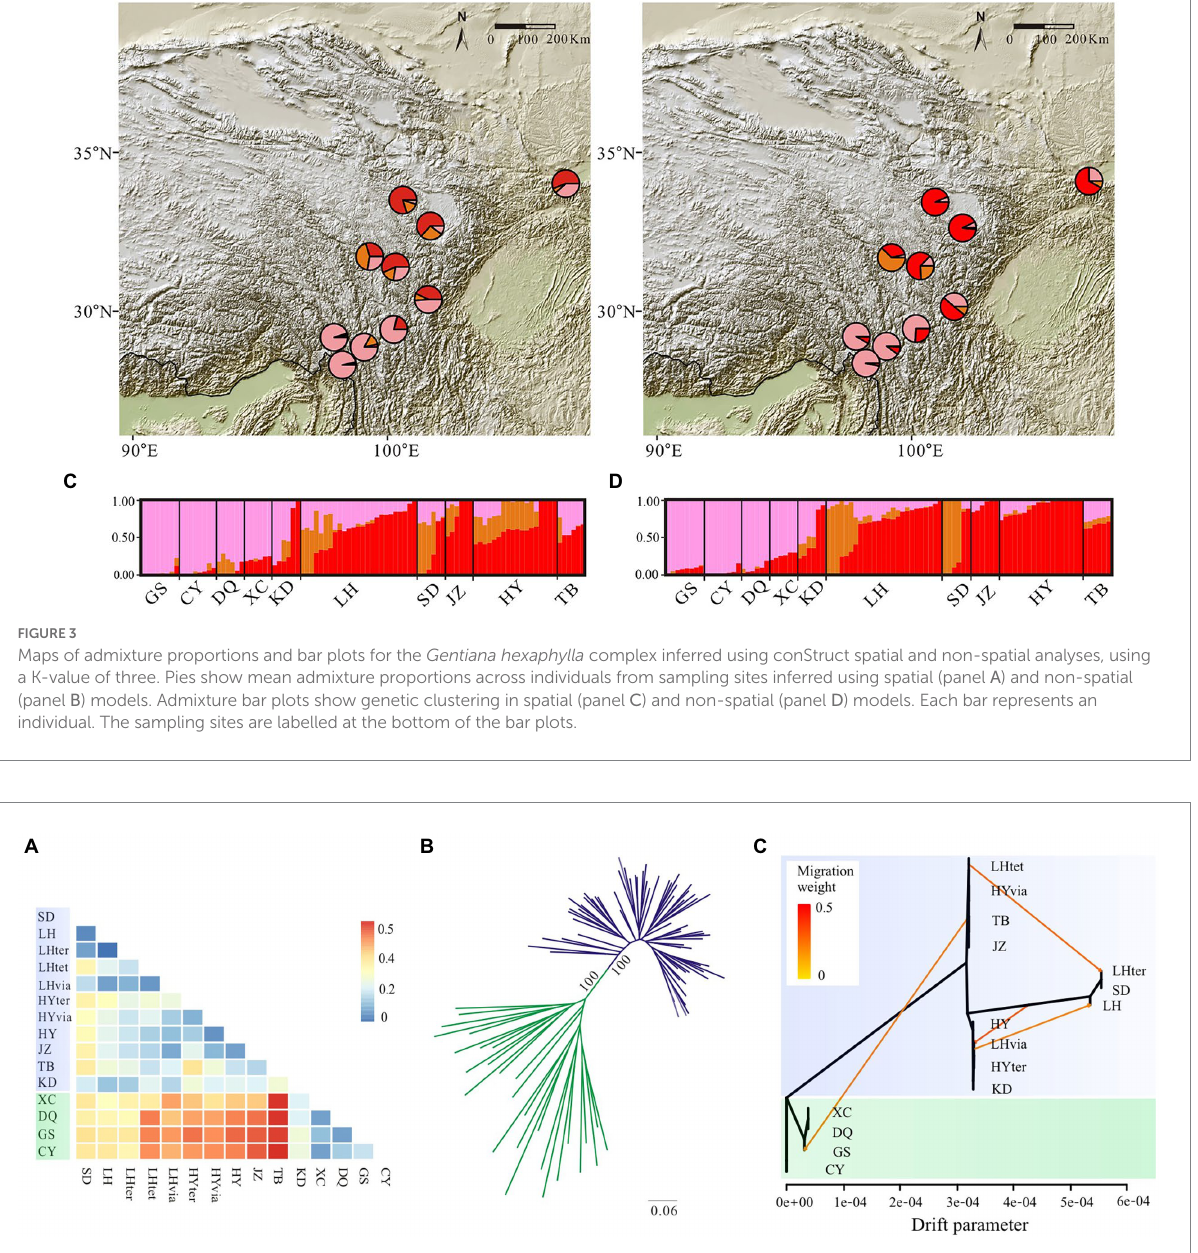
FIGURE 4 Genetic differentiation and phylogenetic relationships based on genomic SNPs in the Gentiana hexaphylla complex. (A) Heatmap of Weir and Cockerham’s F ST between each pair of populations. (B) Unrooted maximum likelihood tree. (C) TreeMix graph showing population splits, and migration edges with migration weights indicated by the colour. The x-axis is the drift parameter reflecting the amount of genetic drift that has occurred between populations and the assumed common ancestral population. Locations in the South HM are showed in green and locations in other regions in